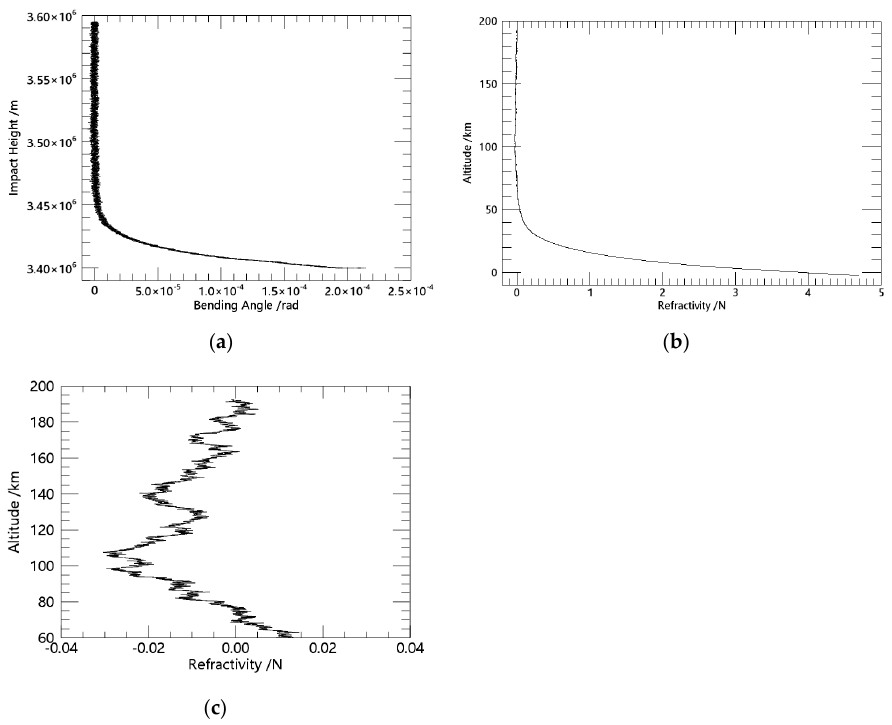
Figure 3. ( a ) Retrieved bending angle versus the ray impact height, ( b ) retrieved refractivity versus altitude, and ( c ) zoomed Mars ionosphere refractivity.